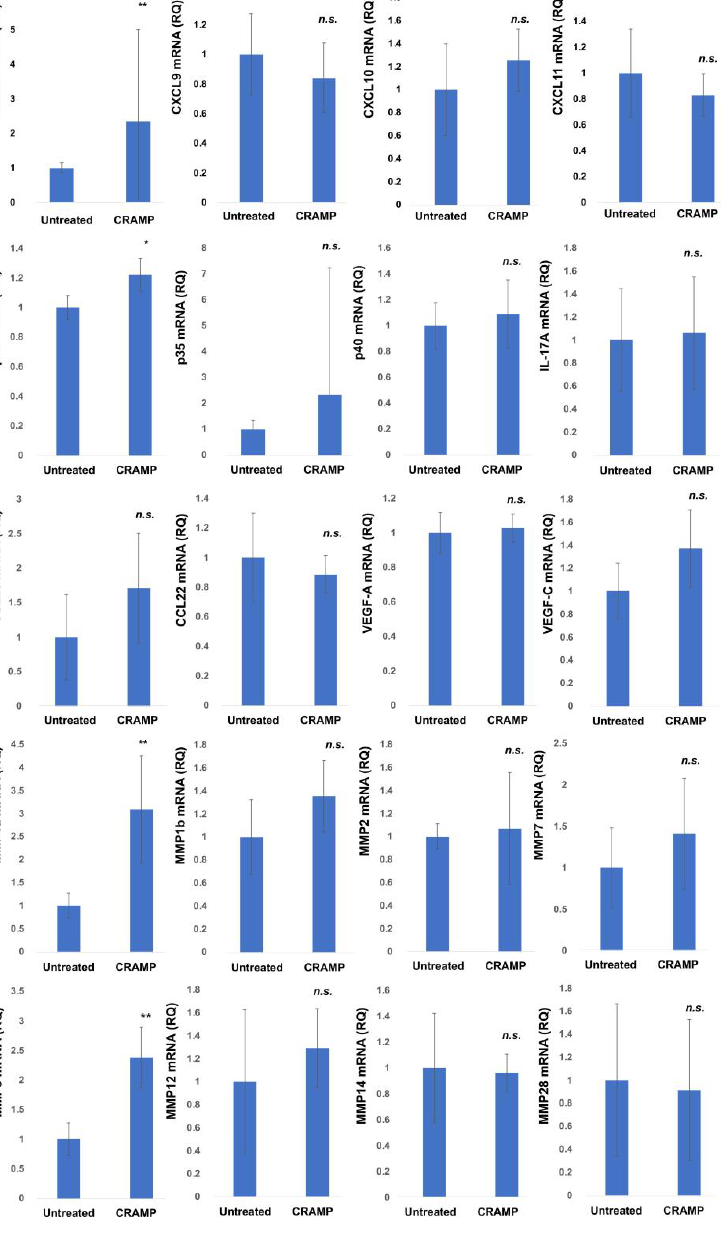
Figure 2. Expression of chemokines, cytokines, and MMPs mRNA in B16F10 melanoma was analyzed by quantitative RT-PCR using the ΔΔ Ct method (n = 15). The data from each donor were obtained by triplicate assays, and then the mean ± SD was calculated (c). * marks a significant ( p < 0.05) difference. ** marks a significant ( p < 0.01) difference. n.s.: not significant. LL-37 increased the mRNA expression and protein production of CXCL5, IL-23p19, and MMP-9 in A375 human melanoma cell lines.